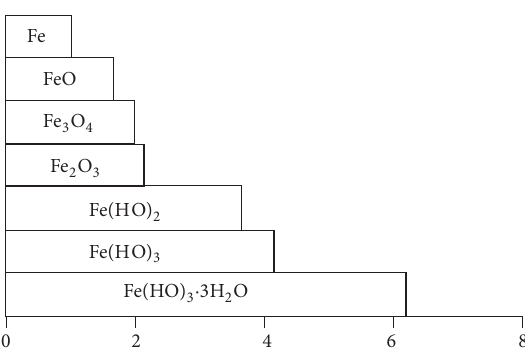
Figure 8: Relative volumes of different iron